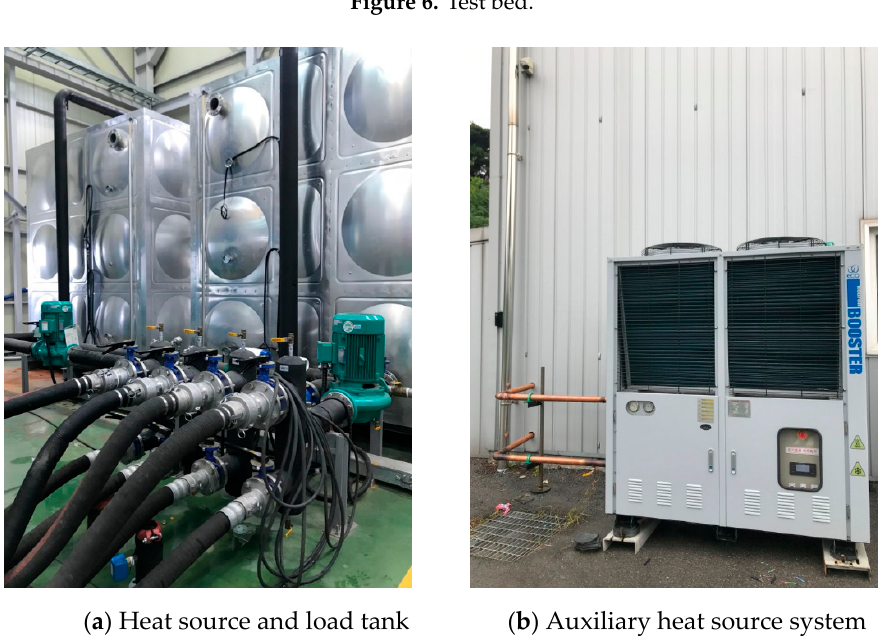
Figure 7. System of test bed .